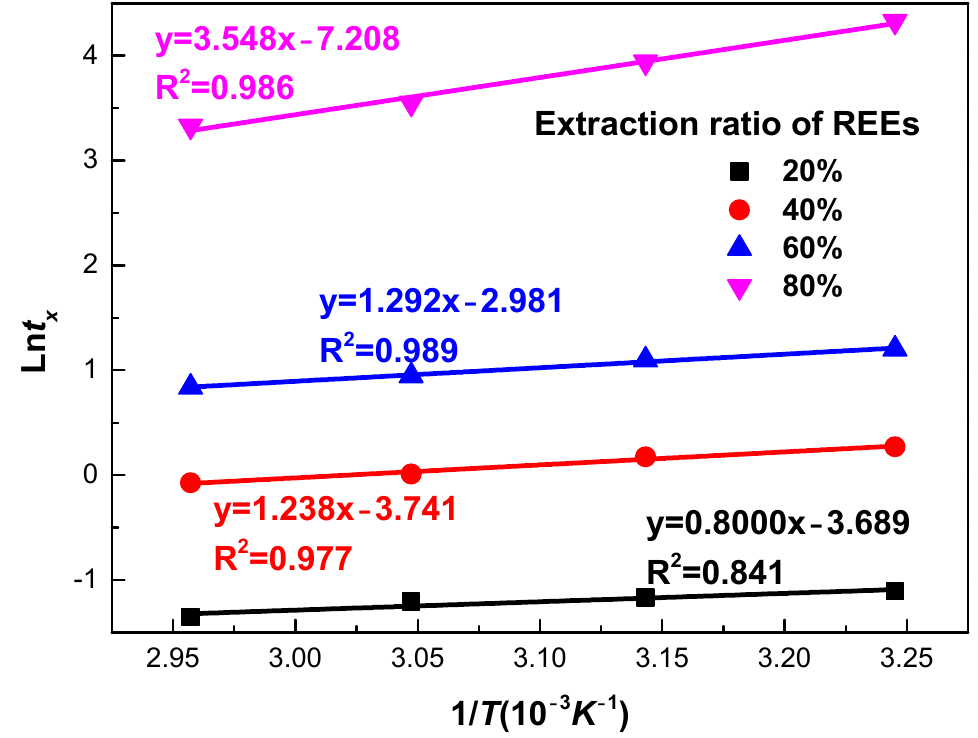
Figure 15. Experimental temperature data for phosphate ore plotted as time-to-different percentages of REEs extraction from experimental data (x = 0.2 to x = 0.8) versus 1/T using the time-to-a-given-fraction method for activation energy determination.